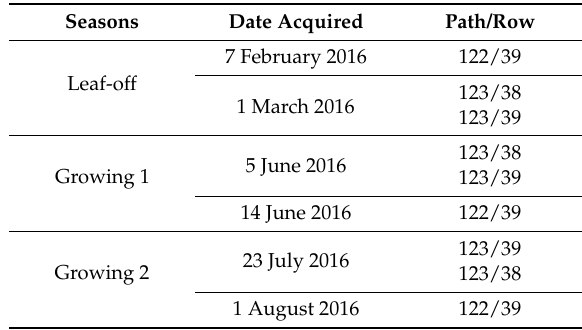
Table 3. Description of the multi-temporal Landsat-8 images.